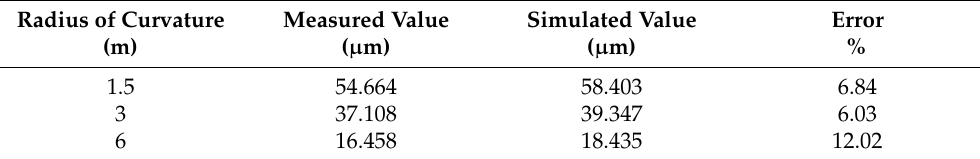
Table 4. Comparison between measured maximum erosion rate and simulated maximum erosion rate under different curvature